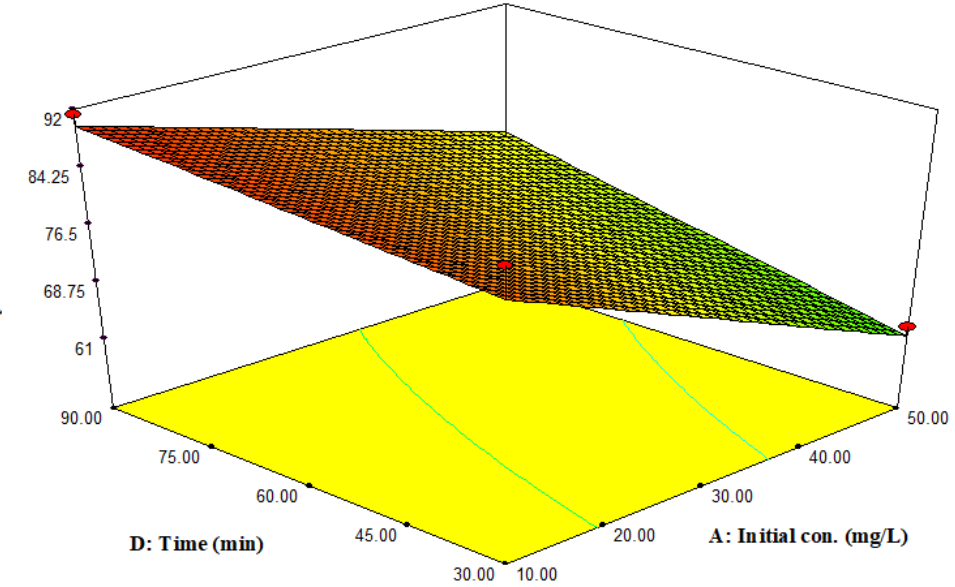
Figure 13. Interaction effect between the contact time (D) and initial dye concentration (A) on the perecentage dye removal at a constant adsorbent dose (C) of 200 (mg/L) and a solution pH (B) of 9.